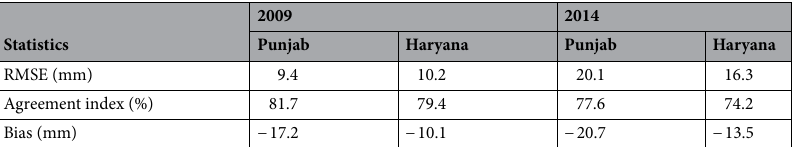
Table 1. Statistical analysis of the WRF model’s performance in simulating daily rainfall over the Punjab and Haryana regions during 2009 and 2014, compared to the observed daily rainfall time series obtained from the TRMM product.